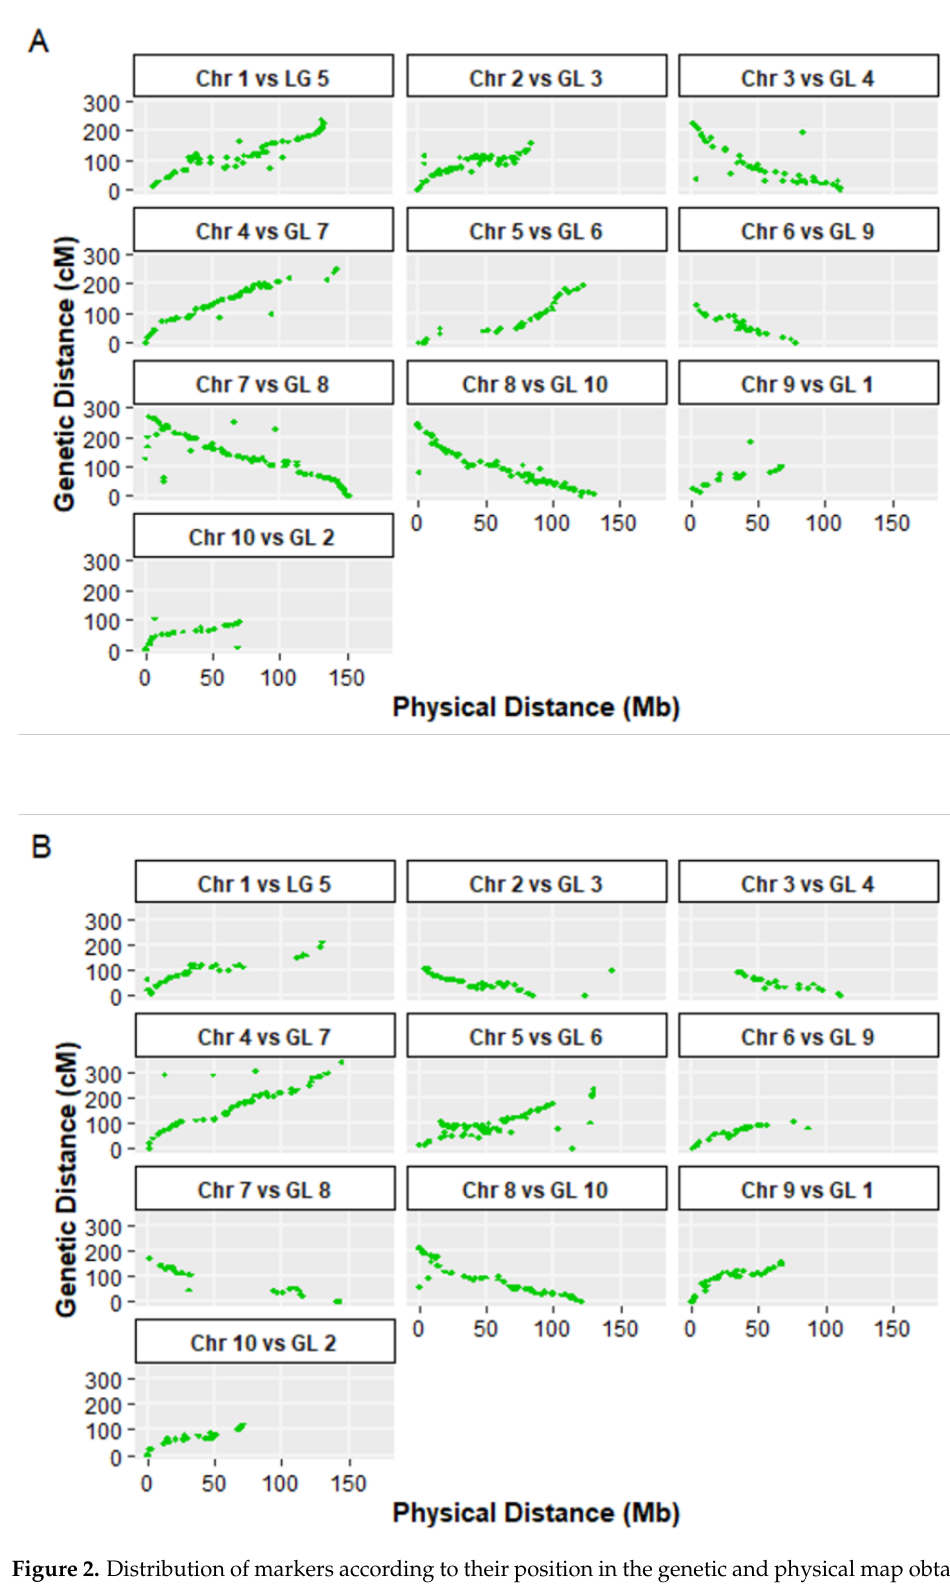
Figure 2. Distribution of markers according to their position in the genetic and physical map obtained in a mapping population (PS010 × WN 124) of A. officinalis . ( A ) Maternal map. ( B ) Paternal map.